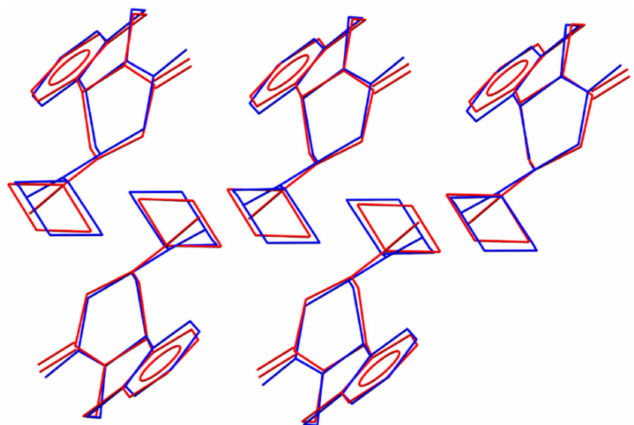
Figure 13. Overlay of the PZQ-HH structure ( blue ) and PZQ Form B ( red ) showing a cluster of five matching PZQ molecules. Hydrogen atoms and positions of water molecules in the PZQ-HH structure were omitted for